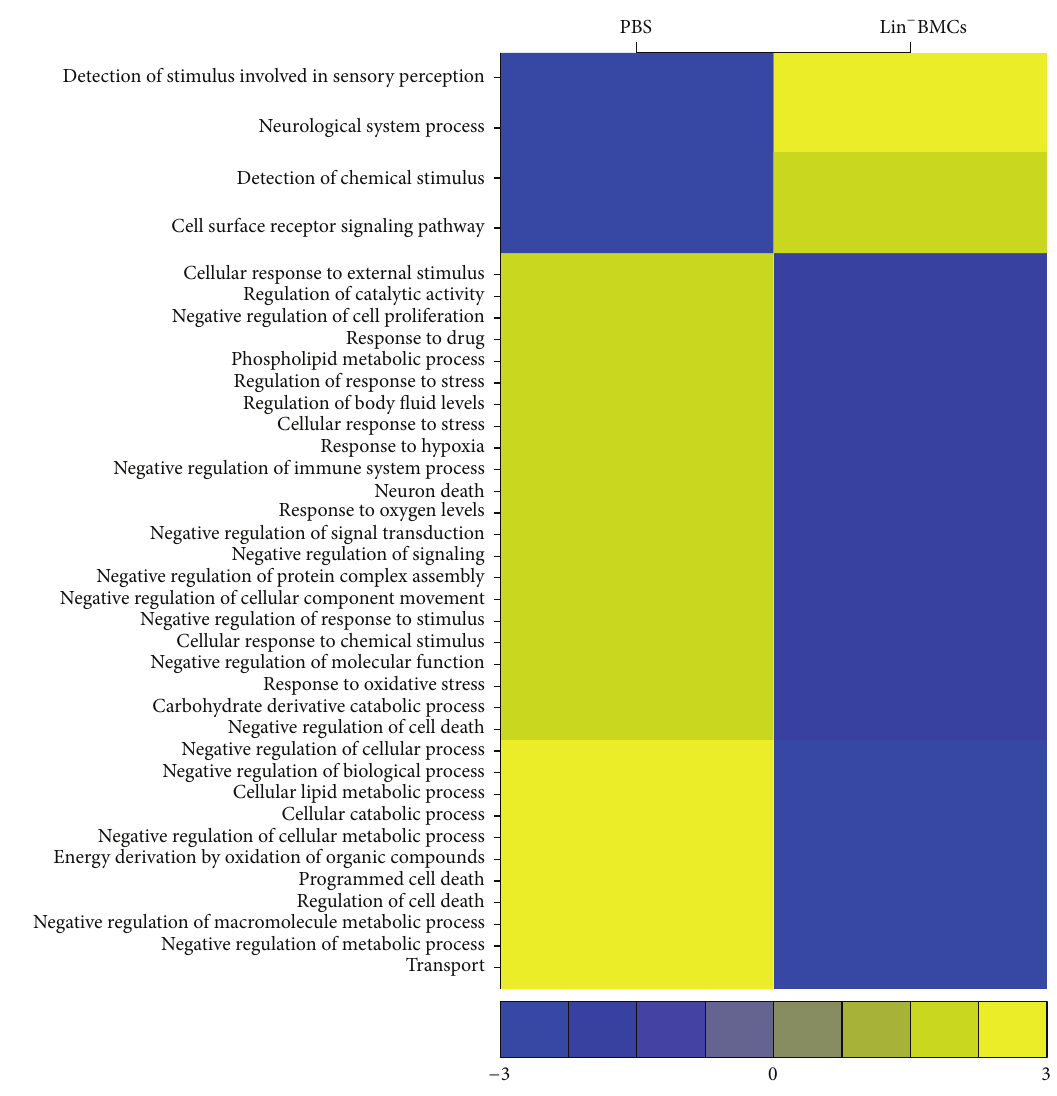
Figure 6: Global changes in gene expression in murine retinas on the 7th day after NaIO 3 -injury. The heat-map represents expression levels of genes representing particular gene ontologies (GOs) with large gene expression changes (fold change > 4) in Lin − BMC-treated eyes compared to PBS-injected control eyes. For a given GO, an average value was computed and subtracted from each observation. Each column comprises a set of horizontal lines, with each line representing a particular GO. Gene expression levels comprising a particular GO are indicated on a color scale, with yellow corresponding to the highest level of expression and blue corresponding to the lowest level; the range of expression rate from the analyzed genes is shown below the graph. The GO terms, listed on the left side of the graph ( 𝑦 -direction), were selected if the genes annotated with the corresponding GO terms were considered statistically significantly